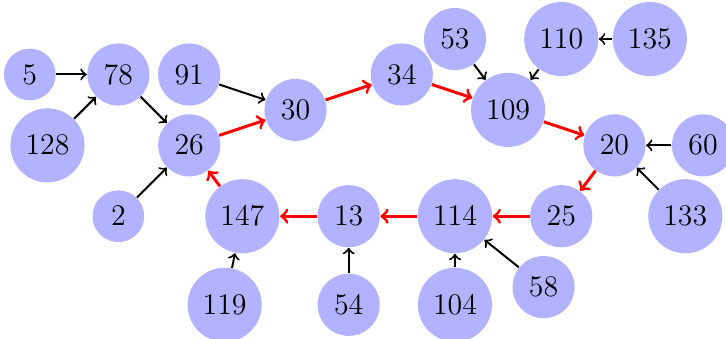
Figure 5: Component containing a cycle of length